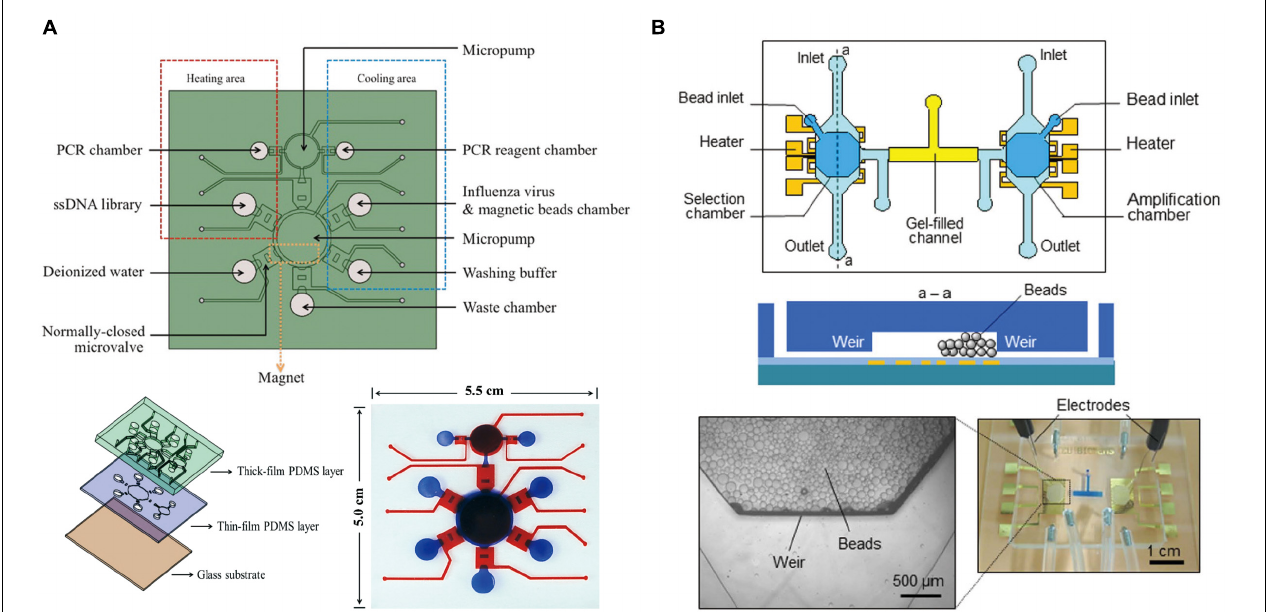
FIGURE 4 | Integrated full-SELEX microfluidic systems. (A) Schematic diagram of the integrated microfluidic SELEX chip. It consisted of two PDMS layers and one glass substrate. (B) Integrated microfluidic SELEX. It includes a selection microchamber and an amplification microchamber interconnected by a gel-filled microchannel: top and cross-sectional schematics. A micrograph of the microchip with microbeads retained in the microchambers and agarose gel (dyed blue for visualization) filling the interconnection channel. Inset: Micrograph of the weir-like flow constriction region with retained beads.